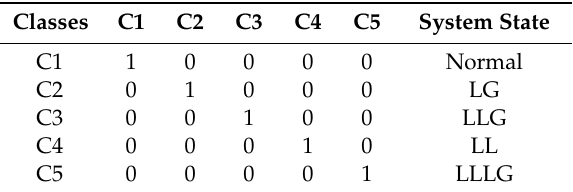
Table 7. Confusion Matrix for Classification.